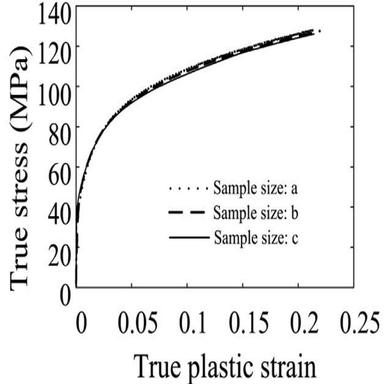
True stress-strain curves from tension test along the RD with different sample sizes: (a) 50 mm gauge length and 12.5 mm width; (b) 4 mm gauge length and 3 mm width; (c) 7 mm gauge length and 4 mm width.